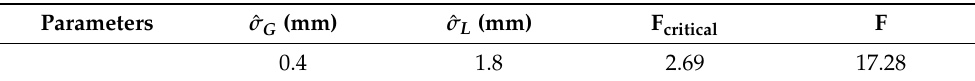
Table 12. The geodetic network precision for both sessions: G —geodetic instrument and L —low-cost instruments.